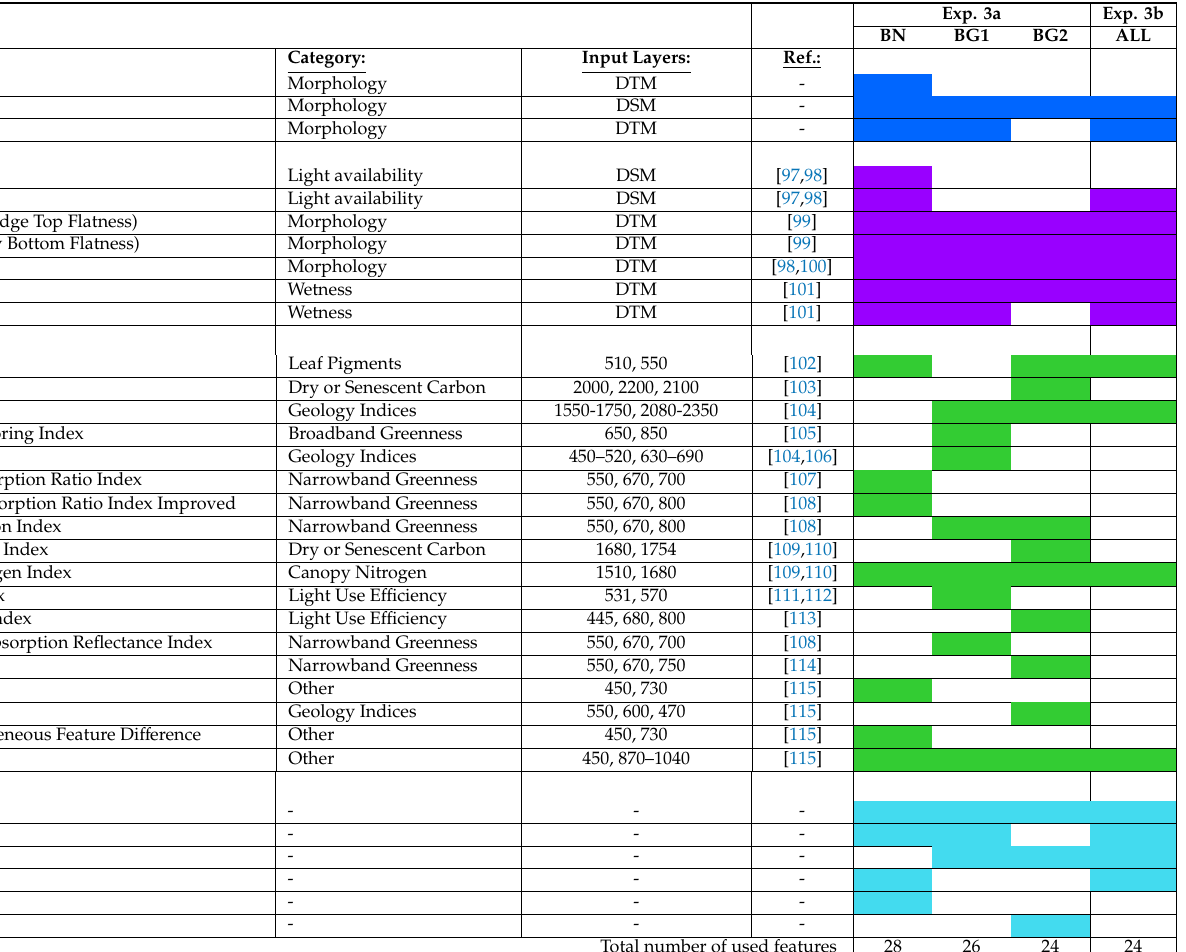
Table 3. List of features selected more than 50% of times from Exp. 2 and used in Exp. 3a / 3b, with corresponding explanations and references. Colors in the right columns mean that the feature was used in the corresponding experiment (3a or 3b). The di ff erent colors are associated to di ff erent feature groups, using same coloring as in Figure